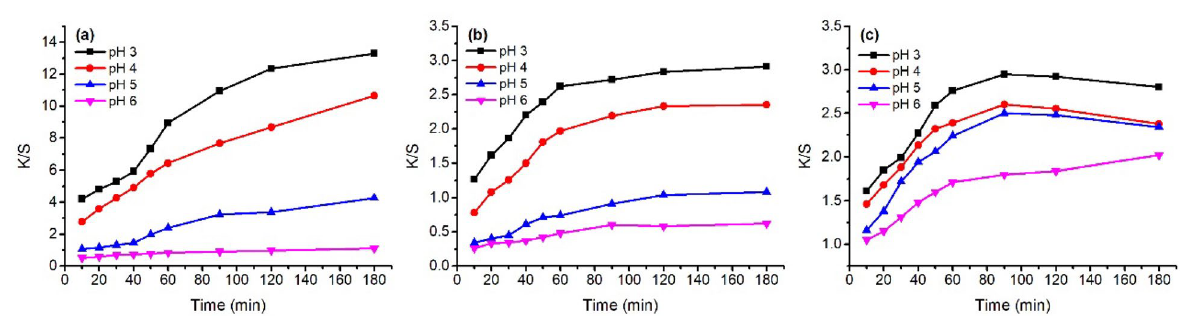
Figure 9. Color strength (K/S) of dyed wool fiber with 2% o.m.f of ( a ) MR, ( b ) GB, and ( c ) GY dyes in water at pH 3–6 at 70 °C.